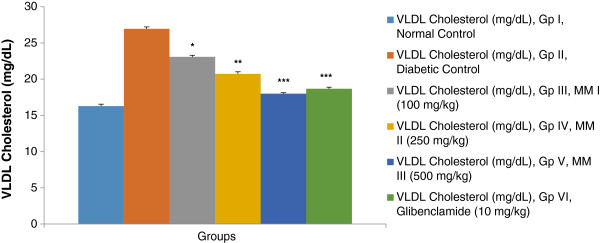
Effect of Melastoma malabathricum Linn. (MM) on level of VLDL cholesterol at different concentrations on STZ induced diabetic rats, compared to standard drug Glibenclamide; values are mean ± SEM; n = 6; *P < 0.05; **P < 0.01; ***P < 0.001; P > 0.05 is considered as non-significant (ns).